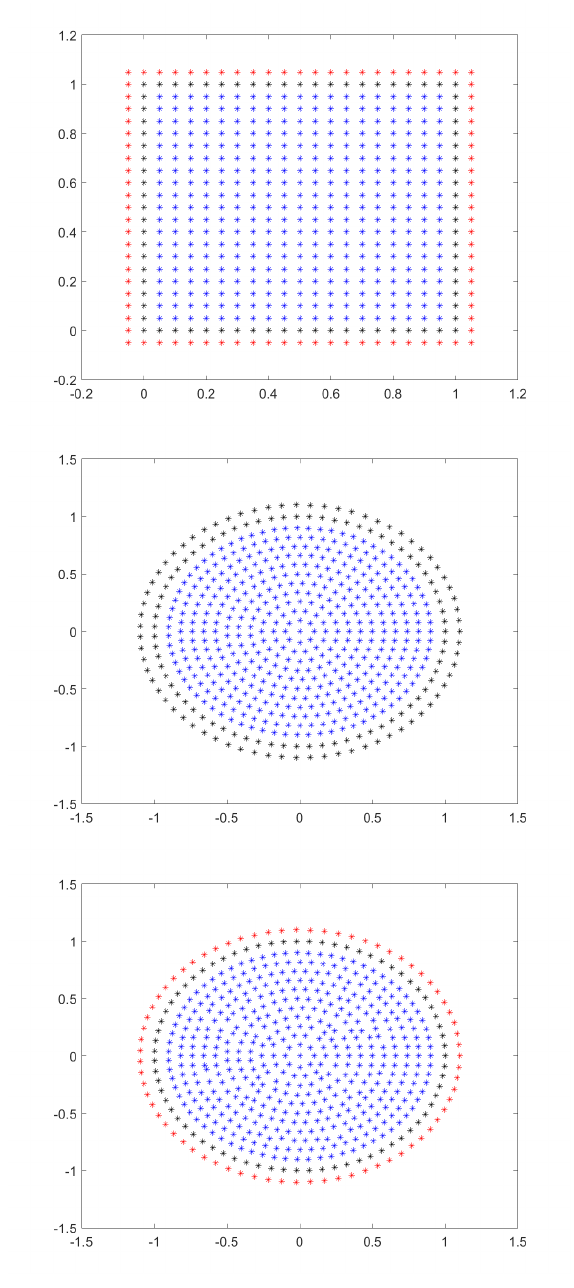
Figure 1. Clouds of